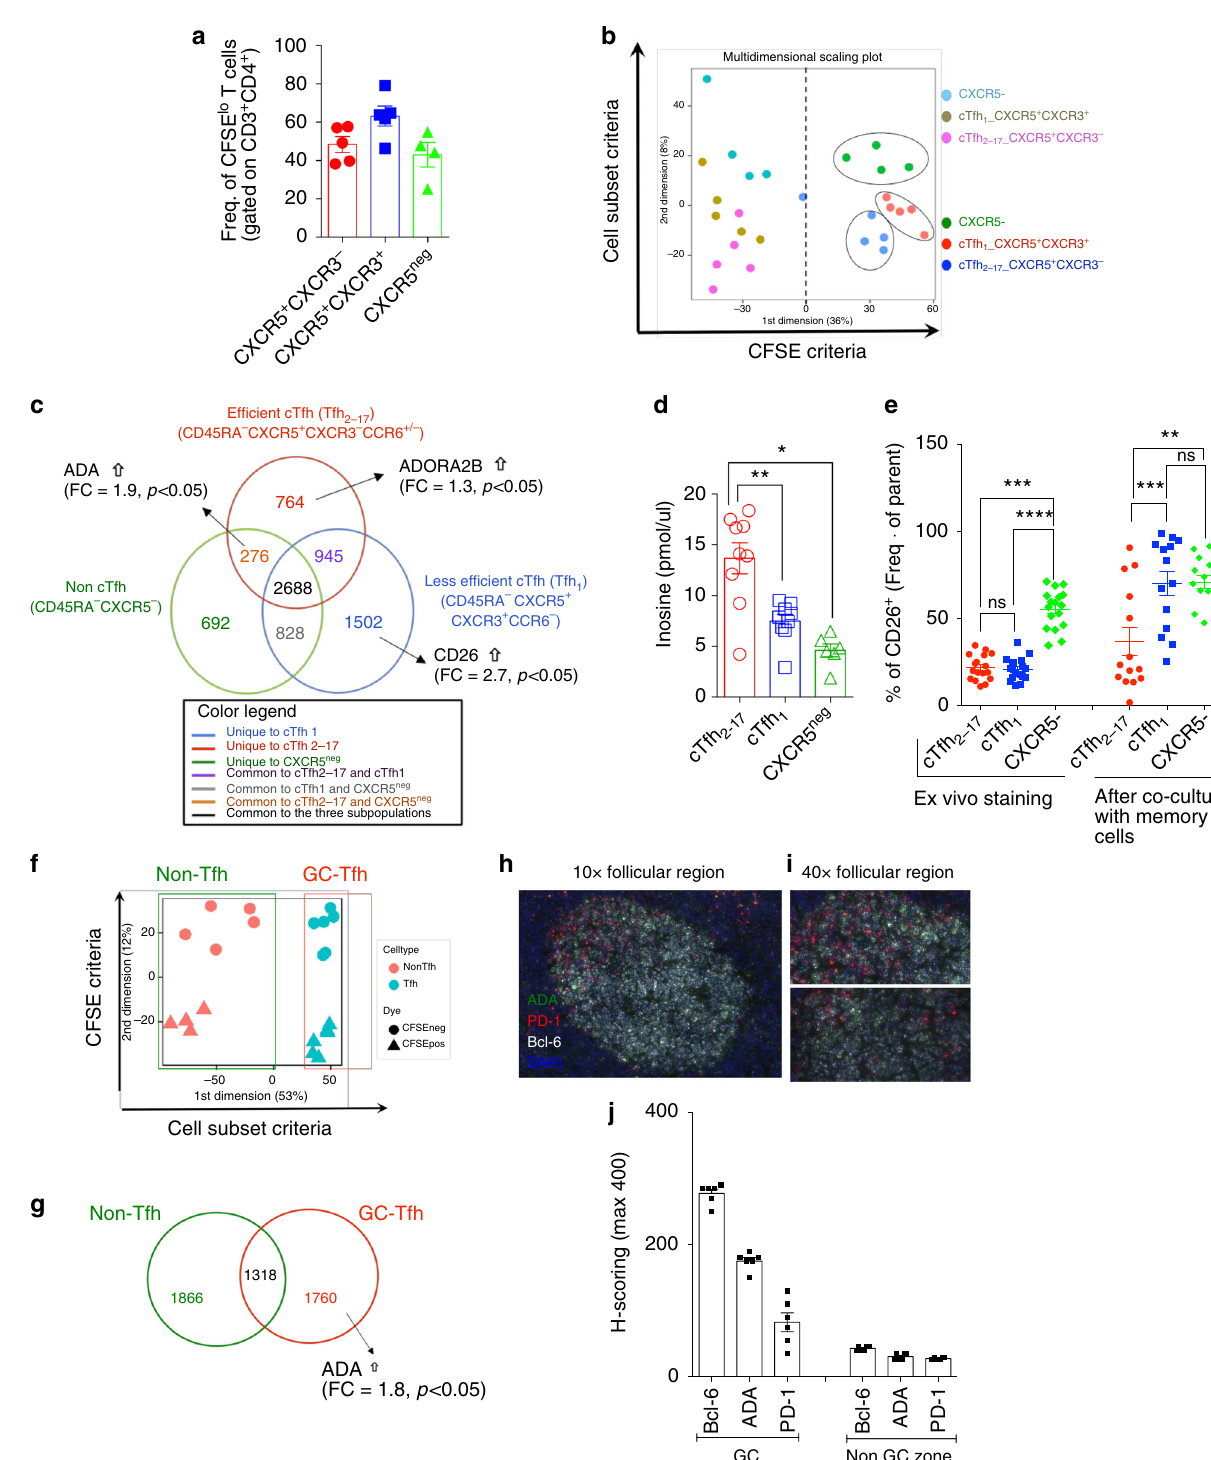
activity (inosine level) and CD26 expression during co-culture of cTfh/non-cTfh subsets (Fig. 1d, e). Inosine levels were found signi fi cantly higher ( p = 0.0039; Wilcoxon t -test) in the super- natant of cTfh 2-17 co-culture, when compared to those from cTfh 1 and non-cTfh CXCR5 − (Fig. 1e), in line with gene array data and presence of ADA-1 activity in this subset. Moreover, ex vivo CD26 staining showed comparable level between cTfh 2-17 and